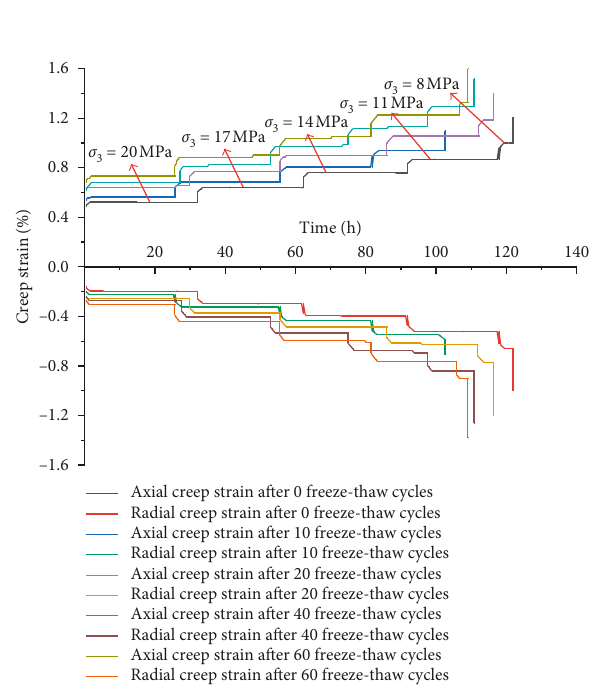
Figure 9: Creep curves under different freeze-thaw